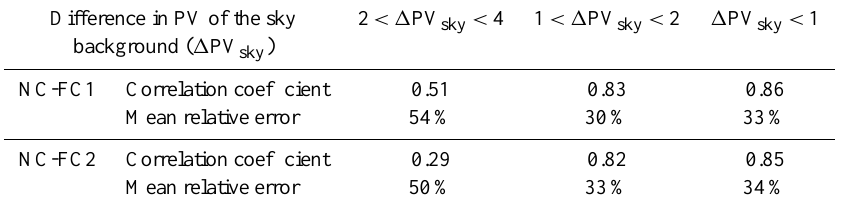
Table 1. Correlation of DOM-Vis and Vaisala scatterometer measurements for different 1 PV sky values. Difference in PV of the sky